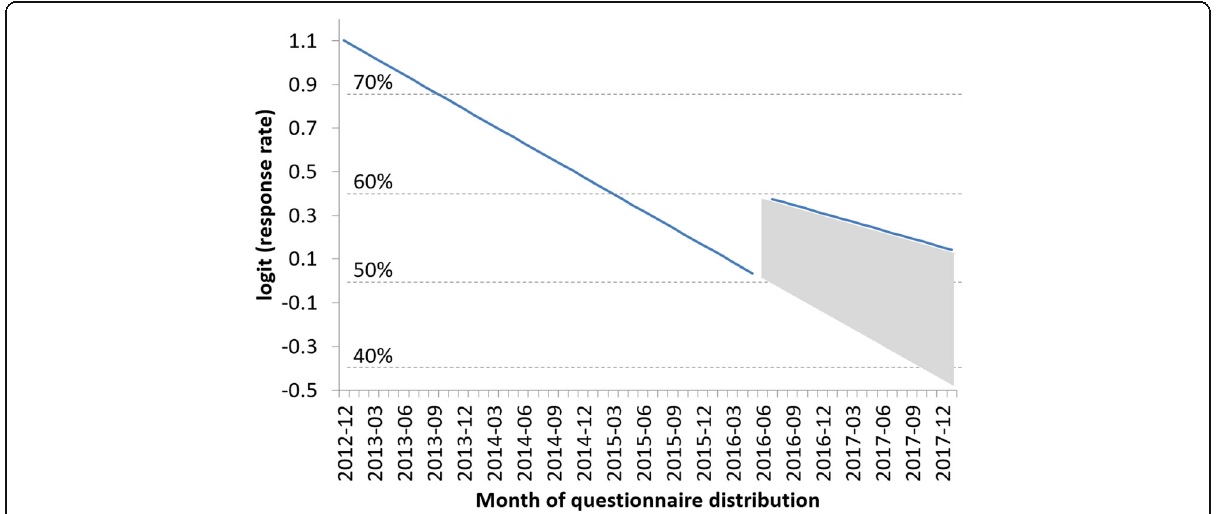
Fig. 1 Trend of response of questionnaire by